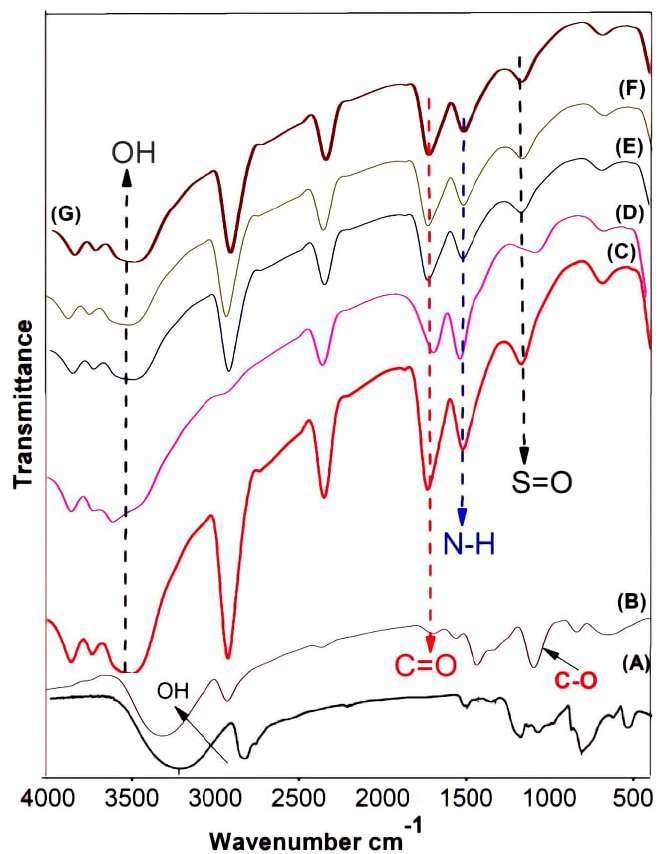
Figure 1. ATR-FTIR spectra of non-cross-linked PVA ( A ), GA-cross-linked PVA ( B ), and GA-cross- linked PVA/PAMPS blend-based membranes prepared using polymer ratio of 1:0.5 ( C ), 1:1 ( D ), 1:1.5 ( E ), 1:2 ( F ), or 1:3 ( G ).